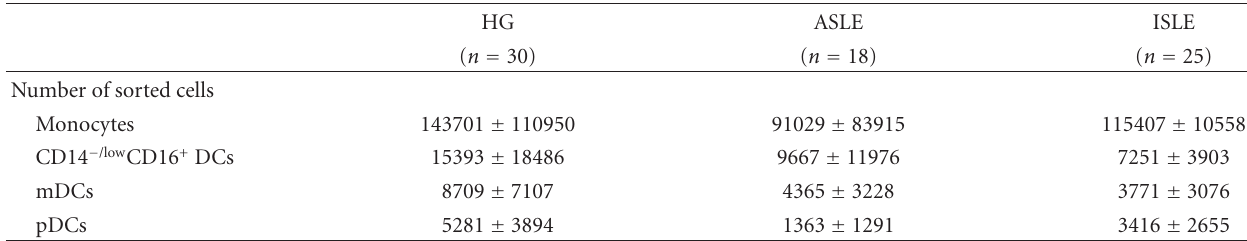
Table 3: Frequency and absolute value of monocytes and peripheral blood dendritic cells in the three studied groups (HG, ASLE, and ISLE). HG ASLE ISLE ( n = 30) ( n = 18) ( n = 25) Frequency (%) Monocytes 3.9 ± 0.97 3.02 ± 1.61 3.56 ± 1.32 CD14 − /low CD16 + DCs 0.54 ± 0.29 0.45 ± 0.30 0.55 ± 0.33 mDCs 0.29 ± 0.18 ∗ 0.21 ± 0.15 ∗∗ 0.29 ± 0.32 pDCs 0.10 ± 0.07 ∗ 0.02 ± 0.03 0.07 ± 0.07 ∗∗∗ Absolute Value (cells/ μ L) Monocytes 284,6 ± 84,2 ∗ 193,3 ± 97,5 228,4 ± 87,1 CD14 − /low CD16 + DCs 39,2 ± 23,2 28,1 ± 20 34,1 ± 19,1 mDCs 21,4 ± 15,1 13,9 ± 11,1 18,2 ± 14 pDCs 7.08 ± 5.16 ∗ 1.24 ± 1.28 ∗∗ 3.82 ± 3.51